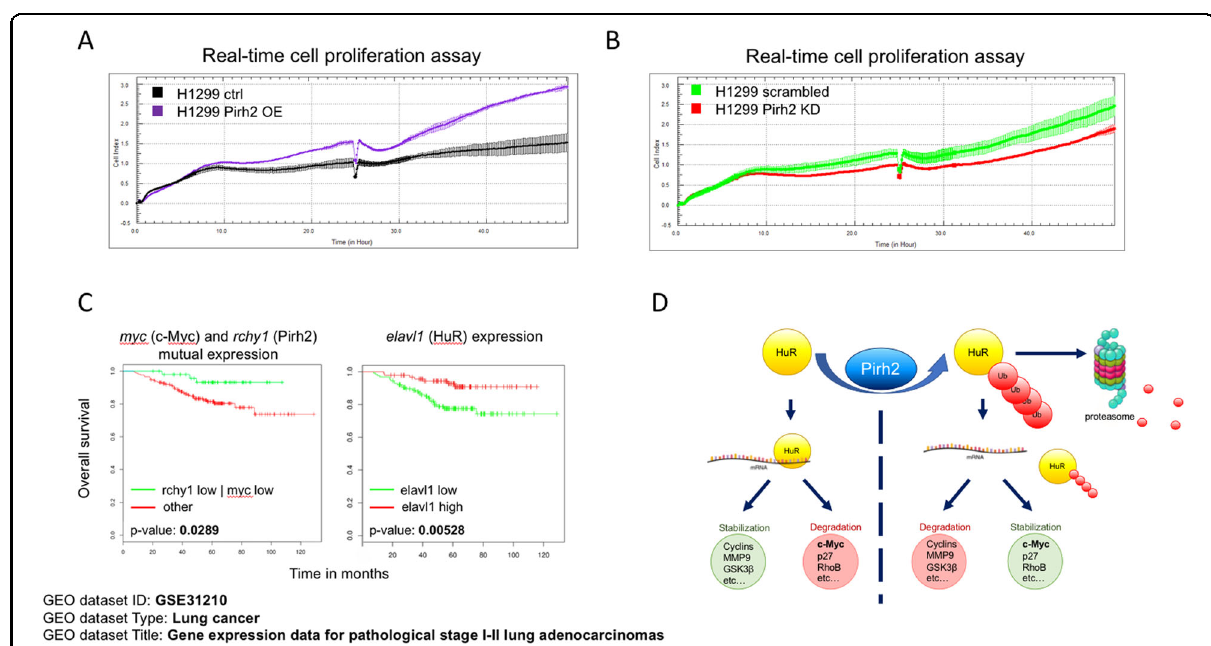
Fig. 7 Pirh2 activates H1299 cell proliferation and cooperates with c-Myc in lung cancer progression. A Pirh2 stimulates proliferation of H1299 cells. Cell index graphs demonstrating the proliferation registered by xCelligence system for H1299 cells with stable Pirh2 overexpression (Pirh2 OE) and control H1299 cells (ctrl). B Pirh2 knockdown suppresses proliferation of H1299 cells. Cell index graphs registered by xCelligence system for H1299 cells with stable Pirh2 knockdown (Pirh2 KD) and control H1299 cells (scrambled). C The bioinformatics analysis of the effect of simultaneous rchy1 and myc genes (coding Pirh2 and c-Myc, respectively), and elavl1 gene (coding HuR protein) expression on lung adenocarcinoma patients ’ (GEO dataset ID: GSE31210) survival probability. P -values are indicated. D Graphical scheme summarizing the role of Pirh2 in HuR protein stability regulation. Pirh2 ubiquitinates HuR that leads to HuR proteasomal degradation and in fl uence on HuR target mRNA